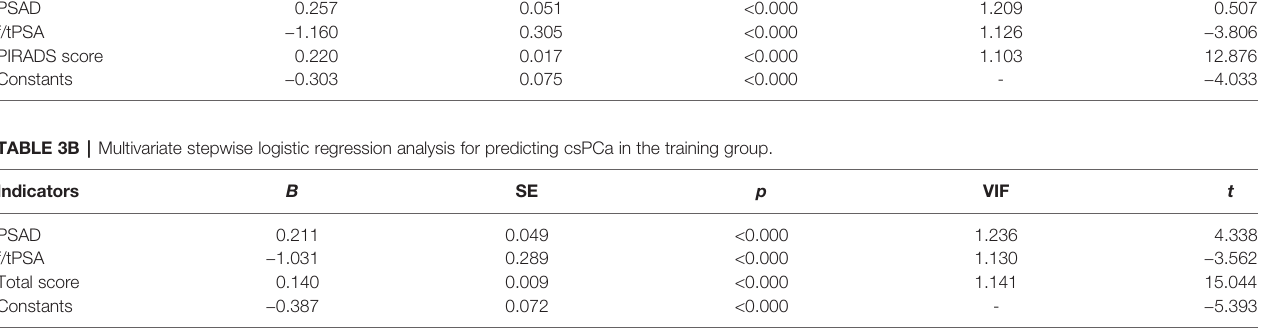
TABLE 3A | Multivariate stepwise logistic regression analysis for predicting csPCa in the training group. Indicators B SE p PSAD